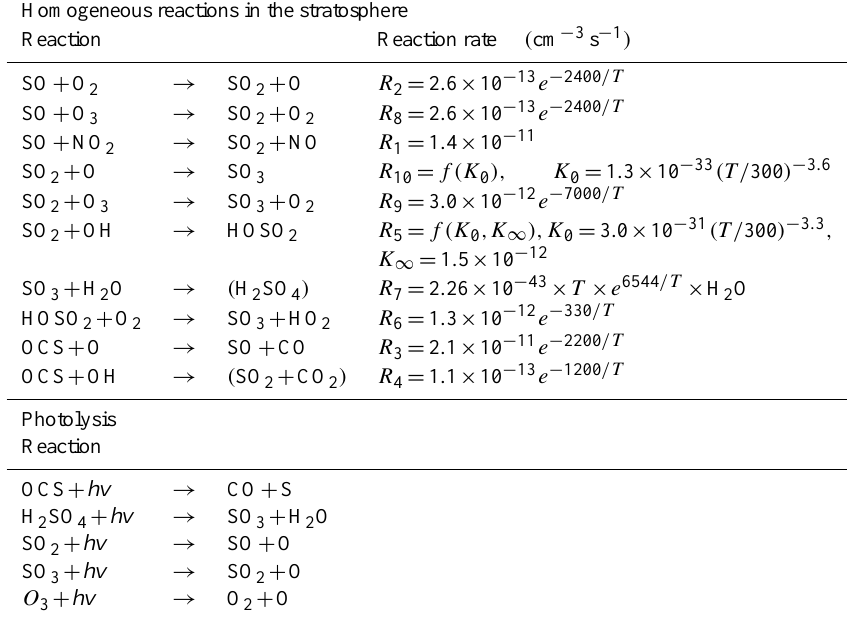
Table 1. Reactions and reaction rate coefficients of stratospheric sulphur chemistry in MAECHAM5–SAM2. Intermediate reactions by- passed where products are given in brackets. Reaction rate constants after JPL/NASA (2003). Homogeneous reactions in the